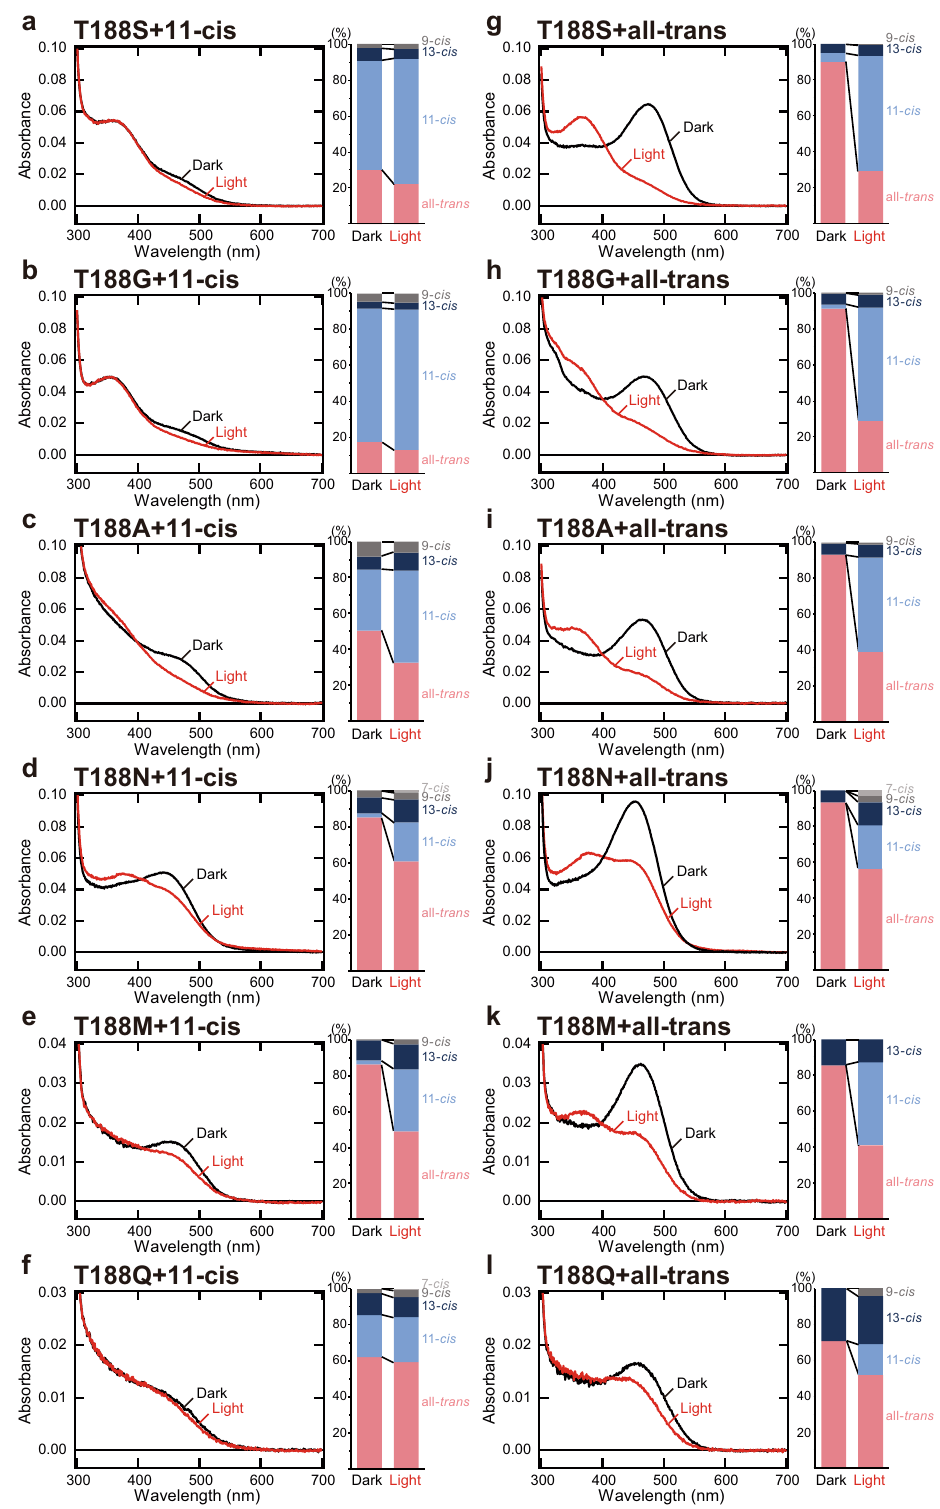
Fig. 6f). Thus, T188C mutant Opn5m can self-regenerate to the original dark state after light irradiation by the combination of the photoisomerization and thermal isomerization of the retinal. Altogether, the T188C mutation of Opn5m drastically altered the binding preference of the retinal isomers and the photoreaction property to partially mimic those of